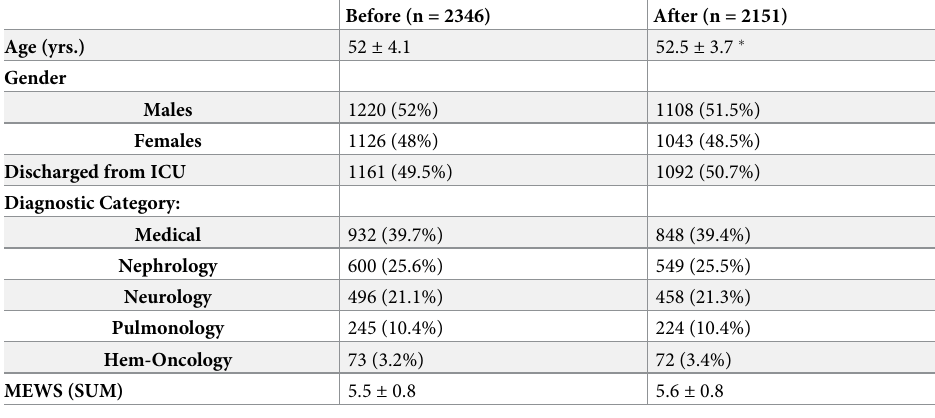
Table 1. Demographic and clinical characteristics of study groups.